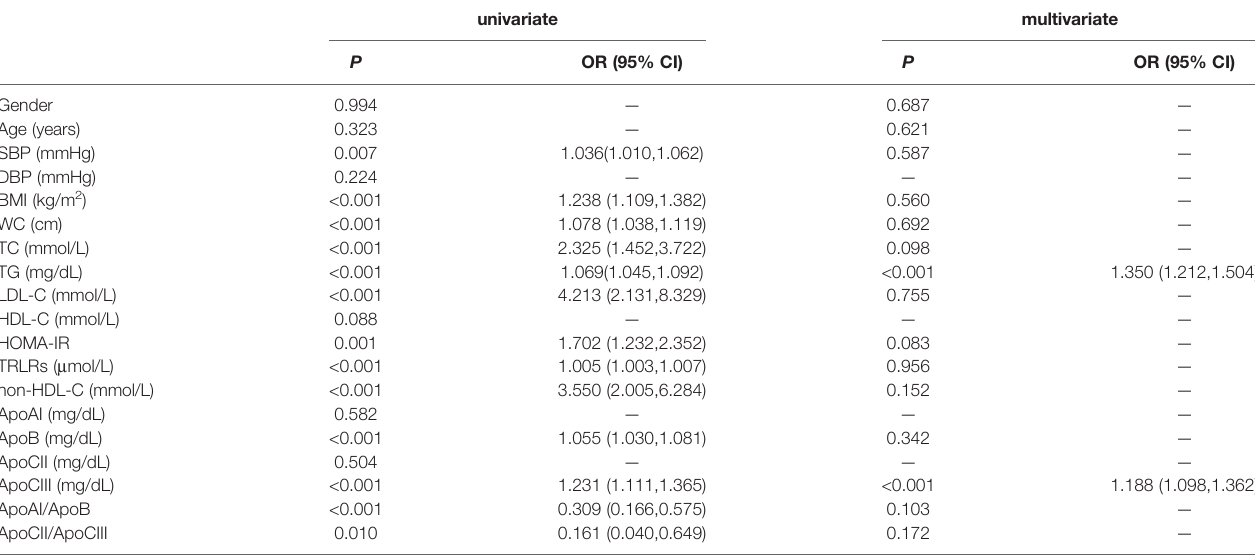
TABLE 4 | Binary logistic regression analysis for assessment of risk factors for postprandial hypertriglyceridemia.